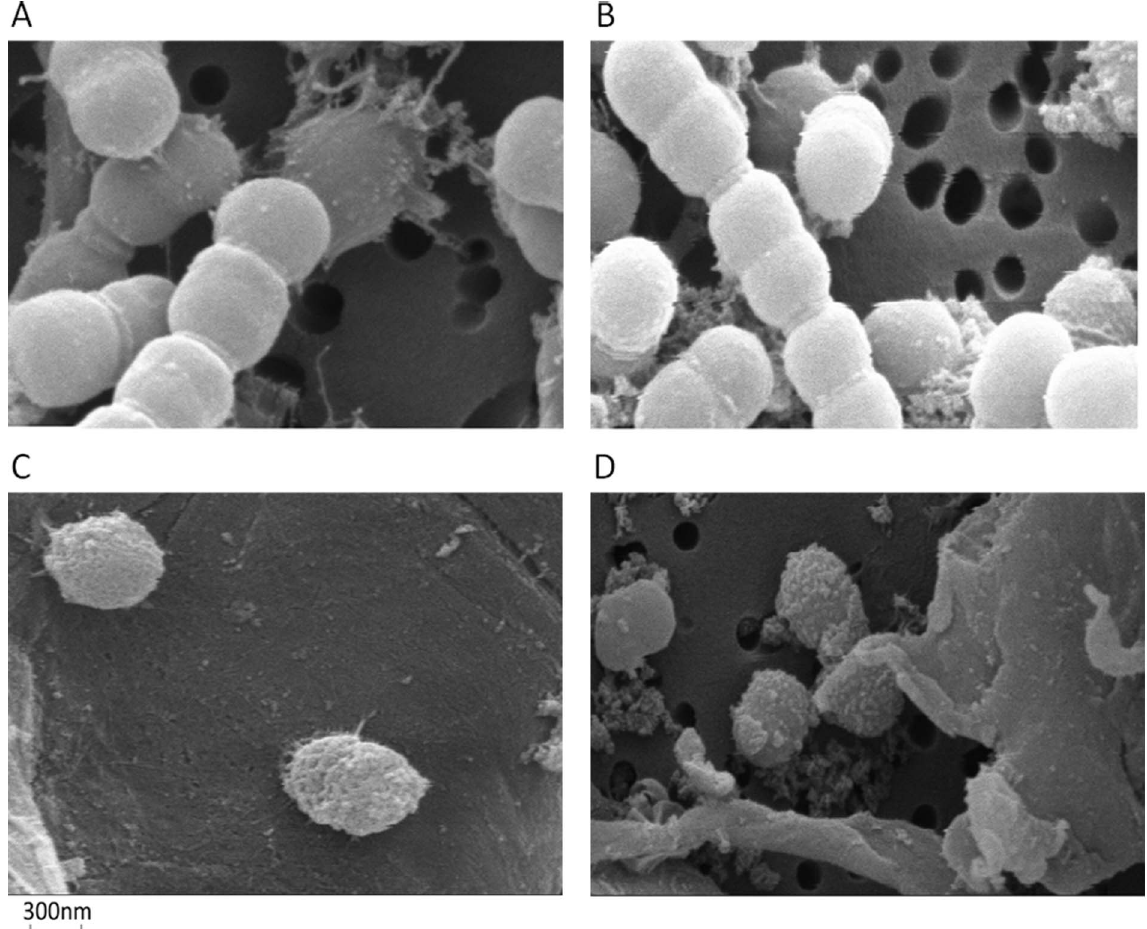
Figure 6. R.flavefaciens 007 cell morphology revealed by scanning electron microscopy. Cells grown on cellobiose: (A) 007C, (B) 007S; or on cellulose: (C) 007C, D) 007S.